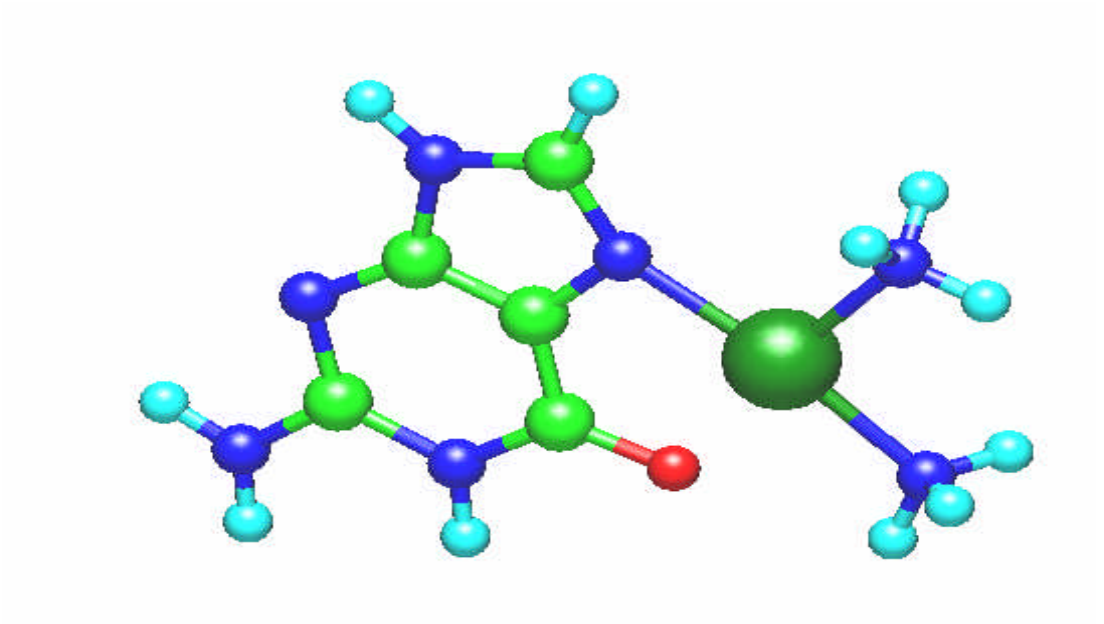
Fig. 1. Molecular structure of the [Pt(NH